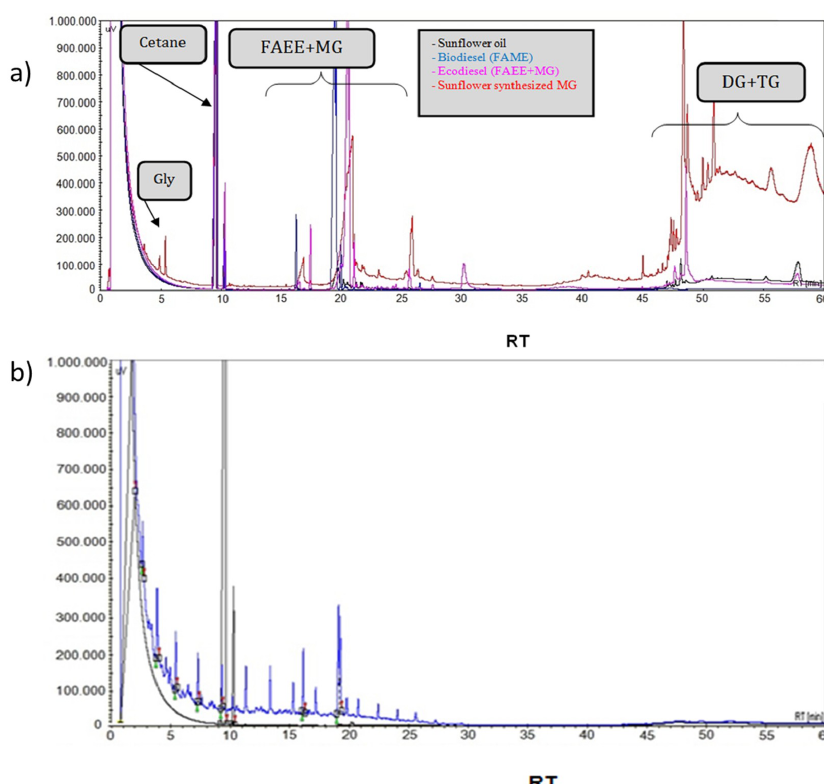
Figure 2. ( a ) Chromatograms related to the alcoholysis of sunflower oil with methanol over OS2; Fatty Acid Methyl Esters (FAME), ethanol, Fatty Acid Ethyl Esters (FAEE), glycerol (gly), monoacylglycerols (MG), diacylglycerols (DG), triacylglycerols (TG), and the initial sunflower oil are plotted in blue, pink, red, and black, respectively. ( b ) Commercial diesel fuel chromatogram.